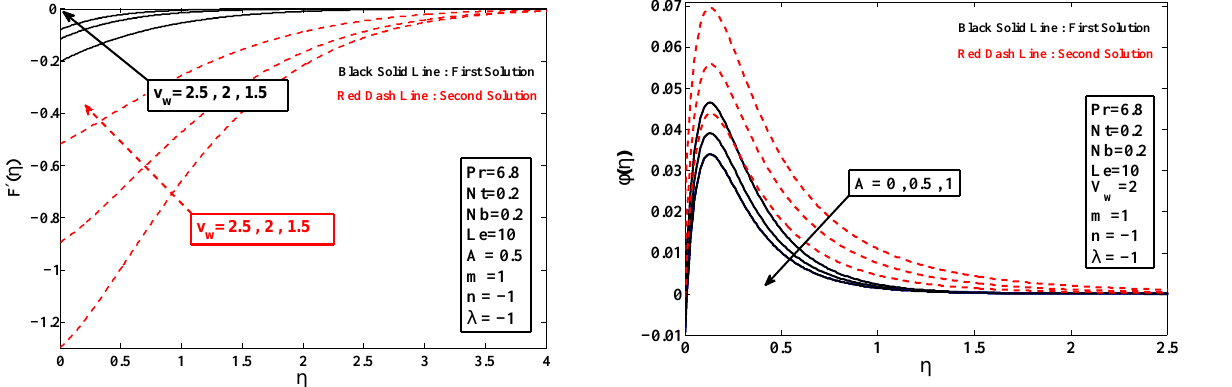
Figure 12: First and second solutions of concentration profile ϕ ( η ) for different values of unsteadiness parameter A .